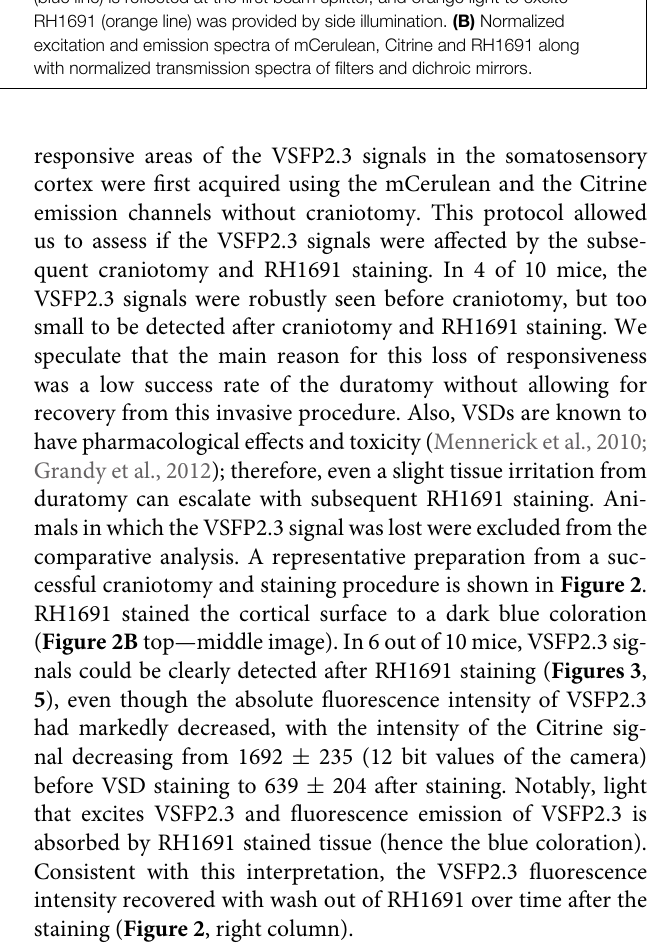
(blue line) is reflected at the first beam splitter, and orange light to excite RH1691 (orange line) was provided by side illumination. (B) Normalized excitation and emission spectra of mCerulean, Citrine and RH1691 along with normalized transmission spectra of filters and dichroic